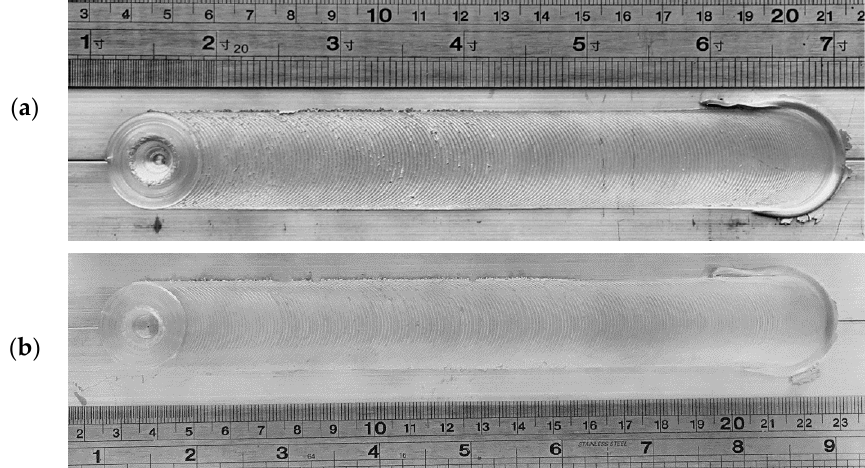
Figure 7. Preliminary “ C ” joints. ( a ) Downwards configuration and ( b ) upwards configuration.